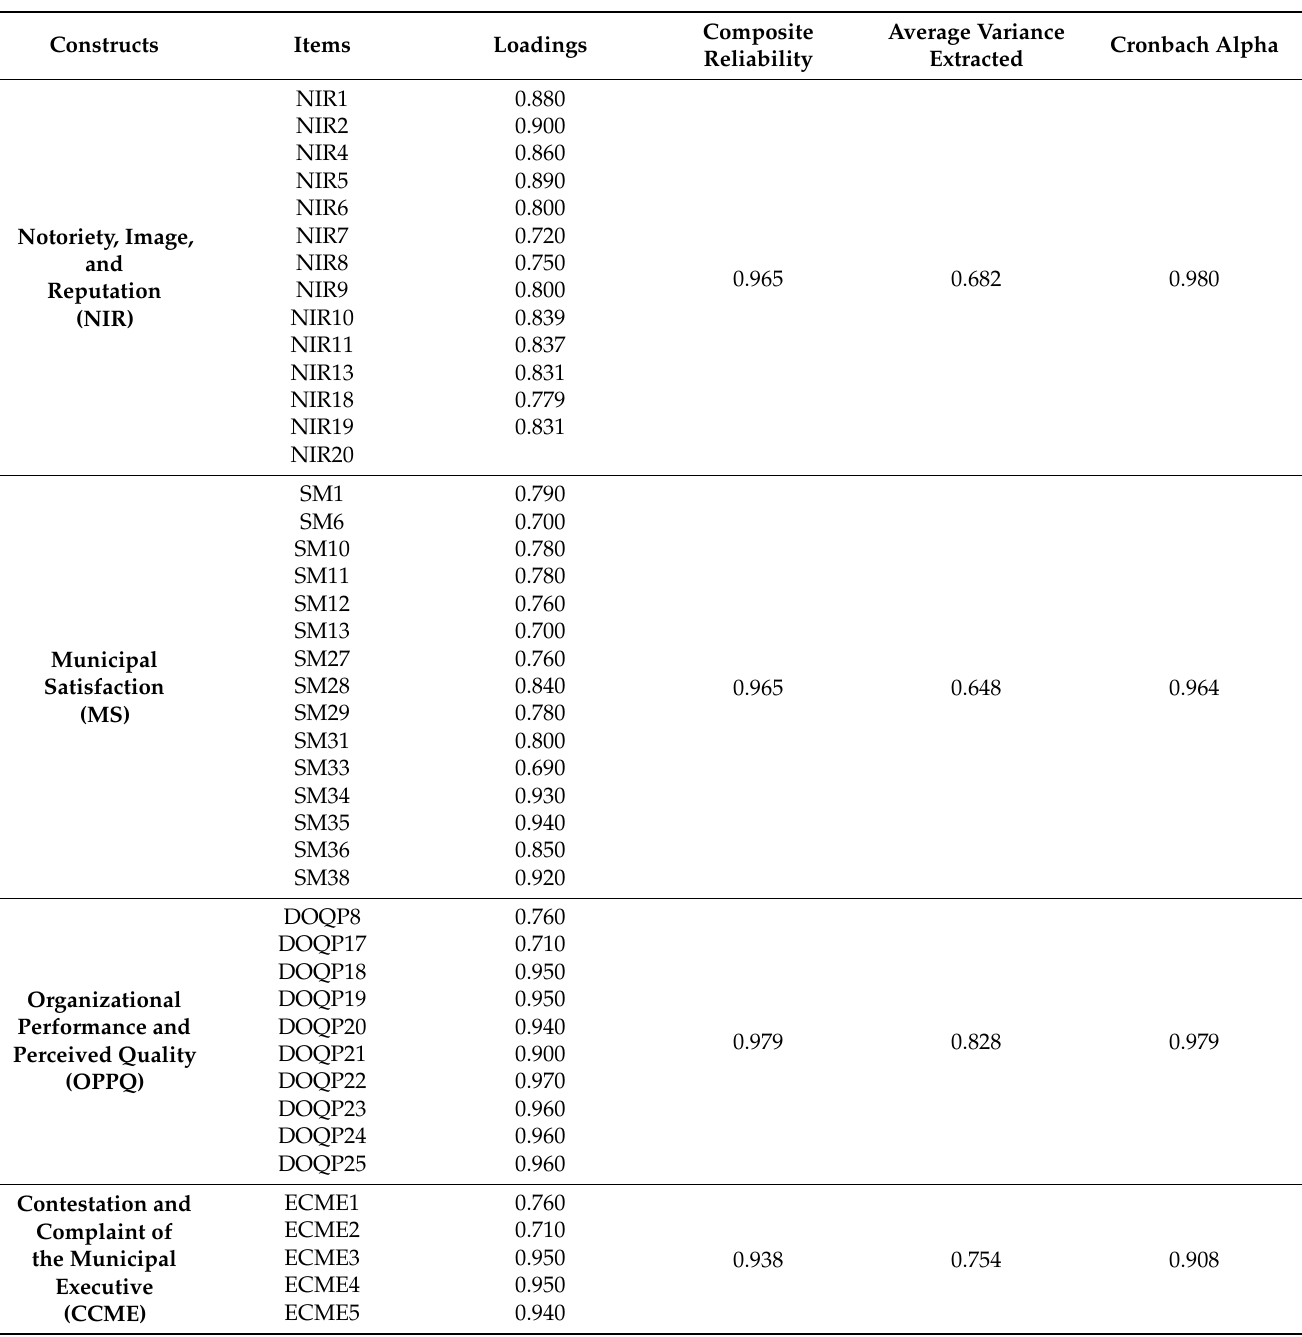
Table 2. Validity and reliability of the constructs.